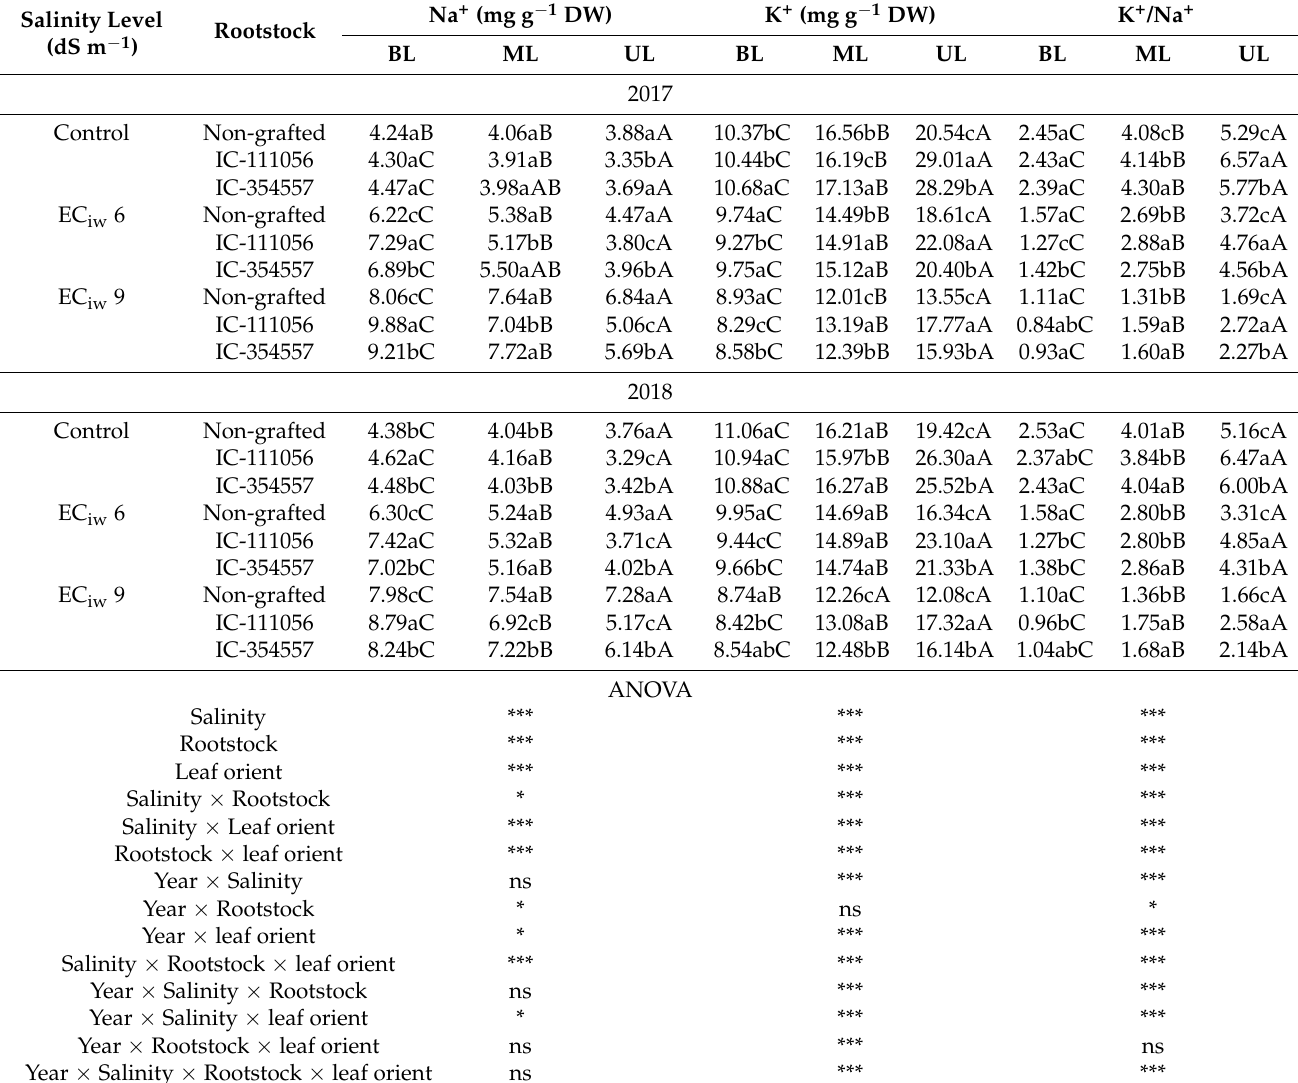
Table 5. Effect of salinity and rootstock on ion partitioning in leaves